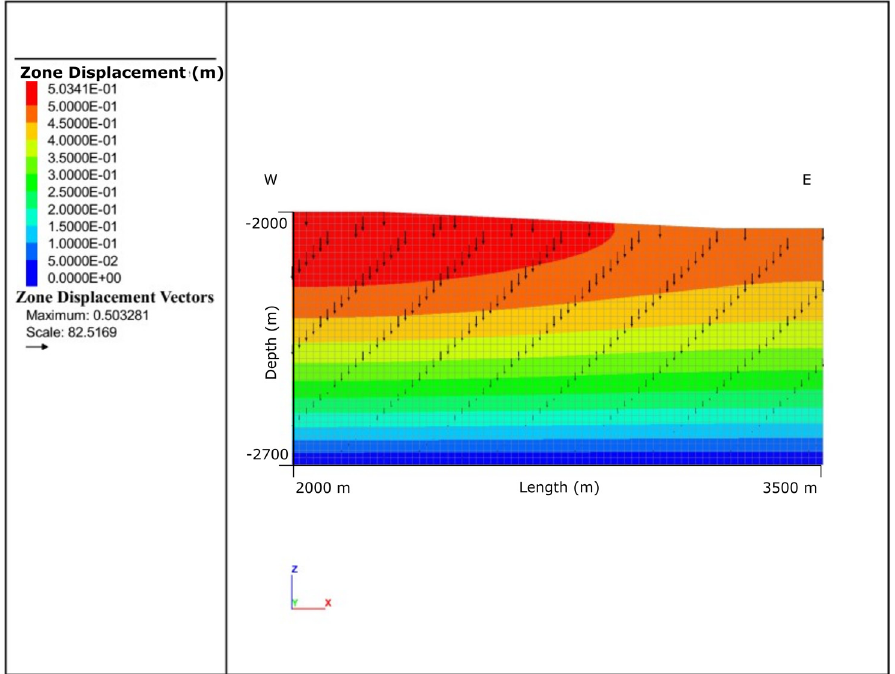
Figure 7. Displacement magnitude (m) and vectors due to hydrate dissociation for 100 years of steady warming of 1 ◦ C. The maximum displacement of 0.5 m is due to vertical compaction due to hydrate dissociation and cannot be considered significant in the large domain range and simulation timeline.